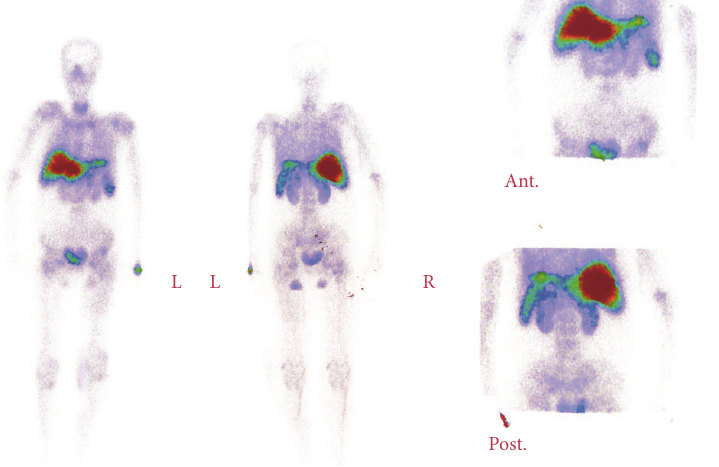
Figure 1: Anterior and posterior whole body bone scan, performed three hours after the intravenous administration of Tc-99m MDP, showed diffuse and intense tracer uptake in the liver and, to a lesser degree, in the spleen, without any remarkable abnormal activity in the skeleton. Decreased skeletal uptake was also